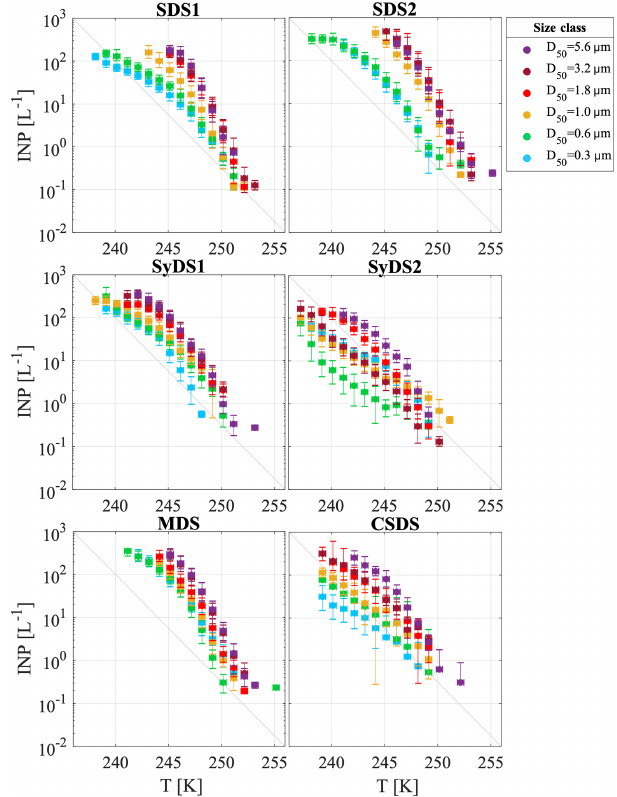
Figure 4. Airborne INP concentrations measured during dust events. INP concentrations per liter of air as a function of temper- ature are presented in different colors for the different particle size classes. Uncertainty in temperature is 0.3K. The grey diagonal line is presented for orientation